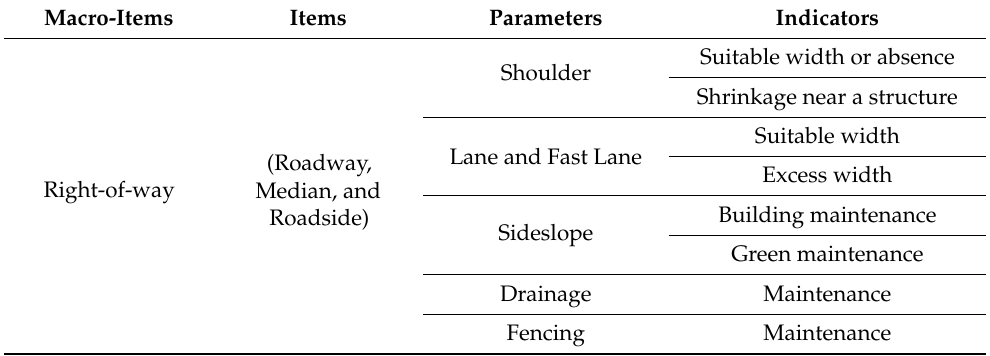
Table 1. Reports distribution in Macro-items, items, parameters, and indicators for general